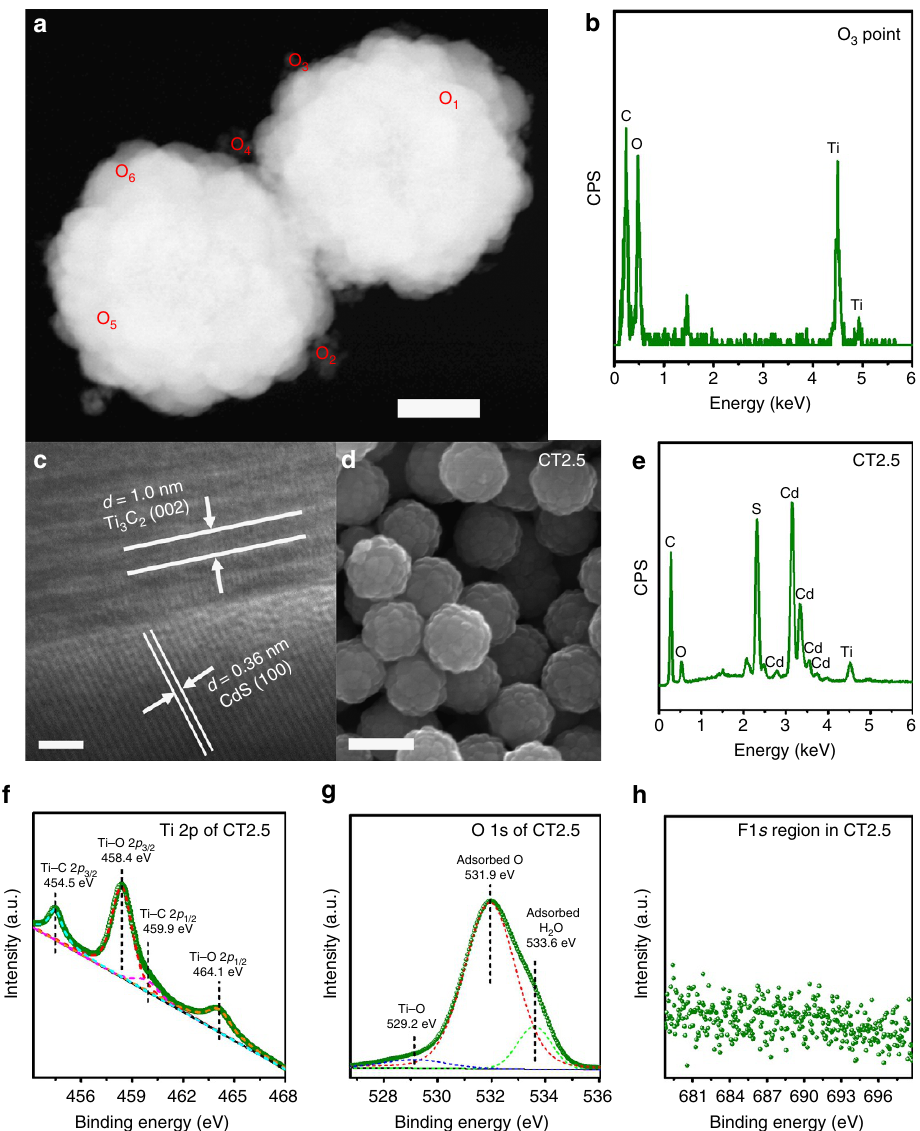
Figure 2 | Morphology and chemical composition of CT2.5. ( a ) A typical high-angle annular dark-field (HAADF) image of CT2.5 and the six different points (O 1 , O 2 , O 3 , O 4 , O 5 and O 6 ) for EDX analysis. ( b ) The EDX spectrum at O 3 point in a . ( c ) The high-resolution TEM image near O 3 point in a . ( d , e ) A typical SEM image of CT2.5 and its corresponding EDX spectrum. ( f – h ) The high-resolution XPS spectra of Ti 2 p , O 1 s and F 1 s for CT2.5. Scale bars, 200nm ( a ), 2nm ( c ) and 500nm ( d